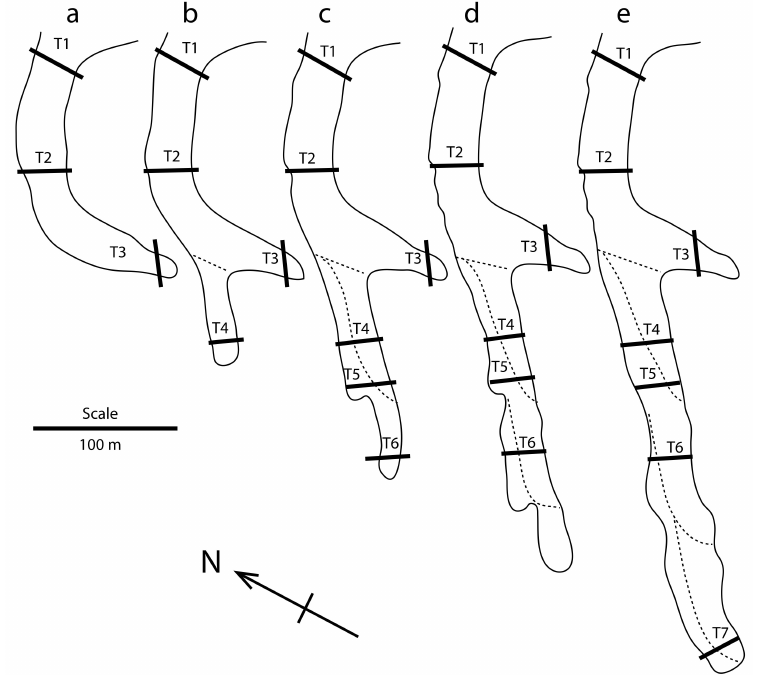
Figure 12. Interpretation of temporal development through Holocene time with study transects marked as reference points: ( a ) phase one; ( b ) phase two; ( c ) phase three; ( d ) phase four; ( e ) phase five. Dashed lines mark boundaries between successive additions to the structure through